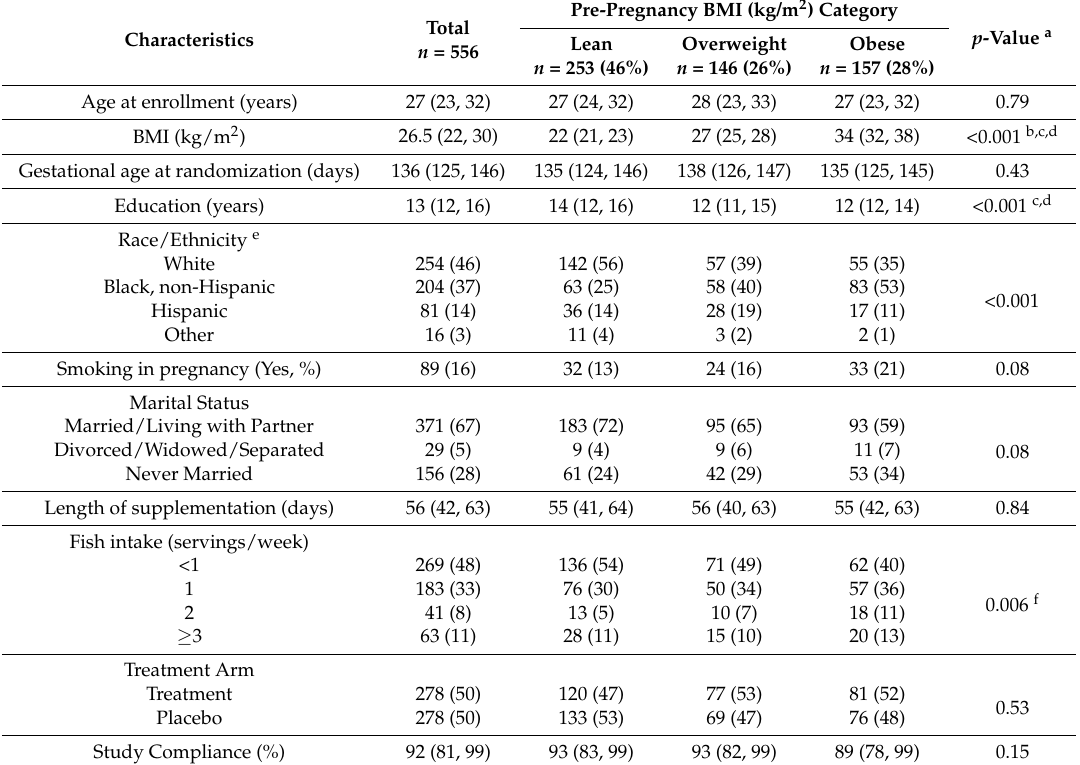
Table 1. Baseline characteristics of participants, overall and by maternal BMI